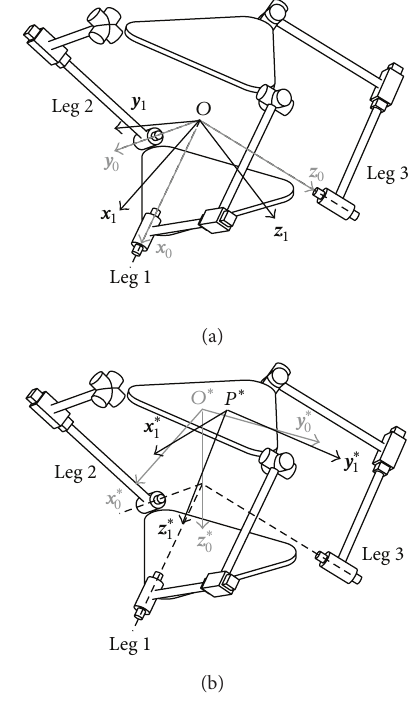
Figure 2: User-defined task